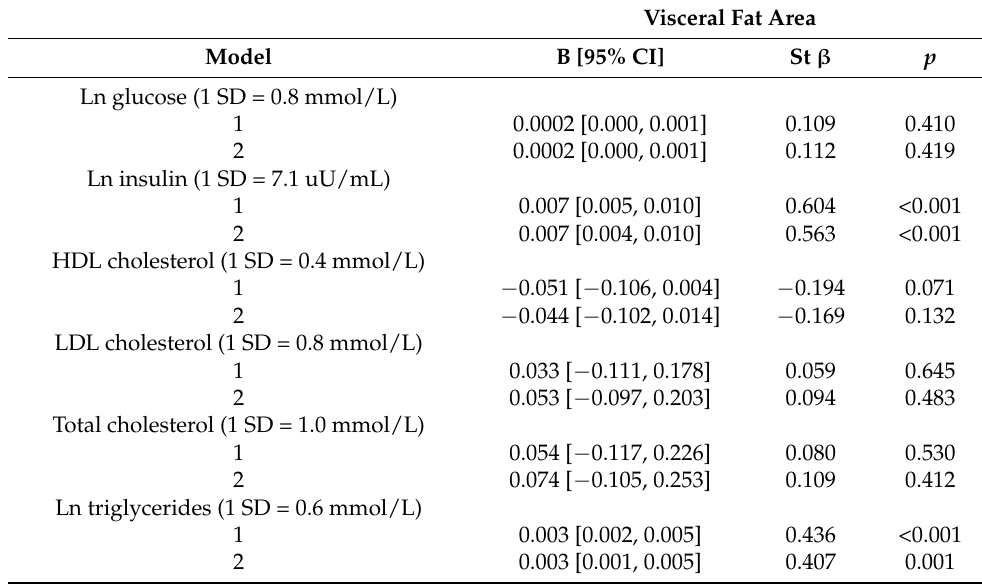
Table 3. Multivariable regression analyses on the associations between visceral fat area and markers of cardiometabolic disease and